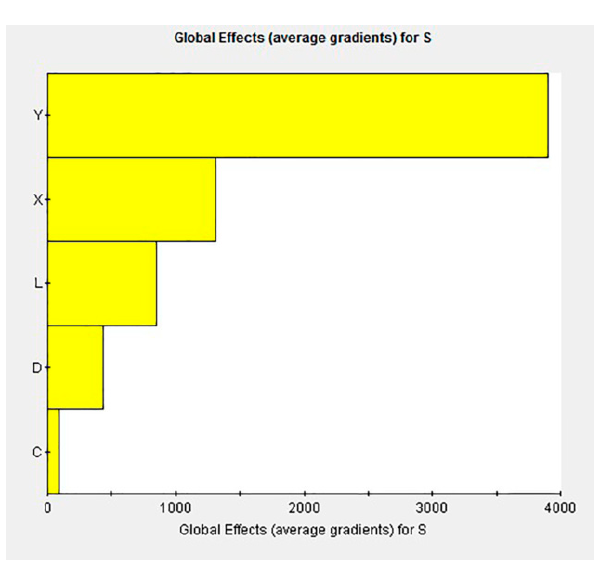
Figure 14. Local effects (gradients) for S.